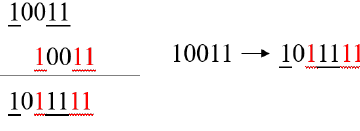
Figure 3: Example of adjacent correlation. Figure 4: Example of cross